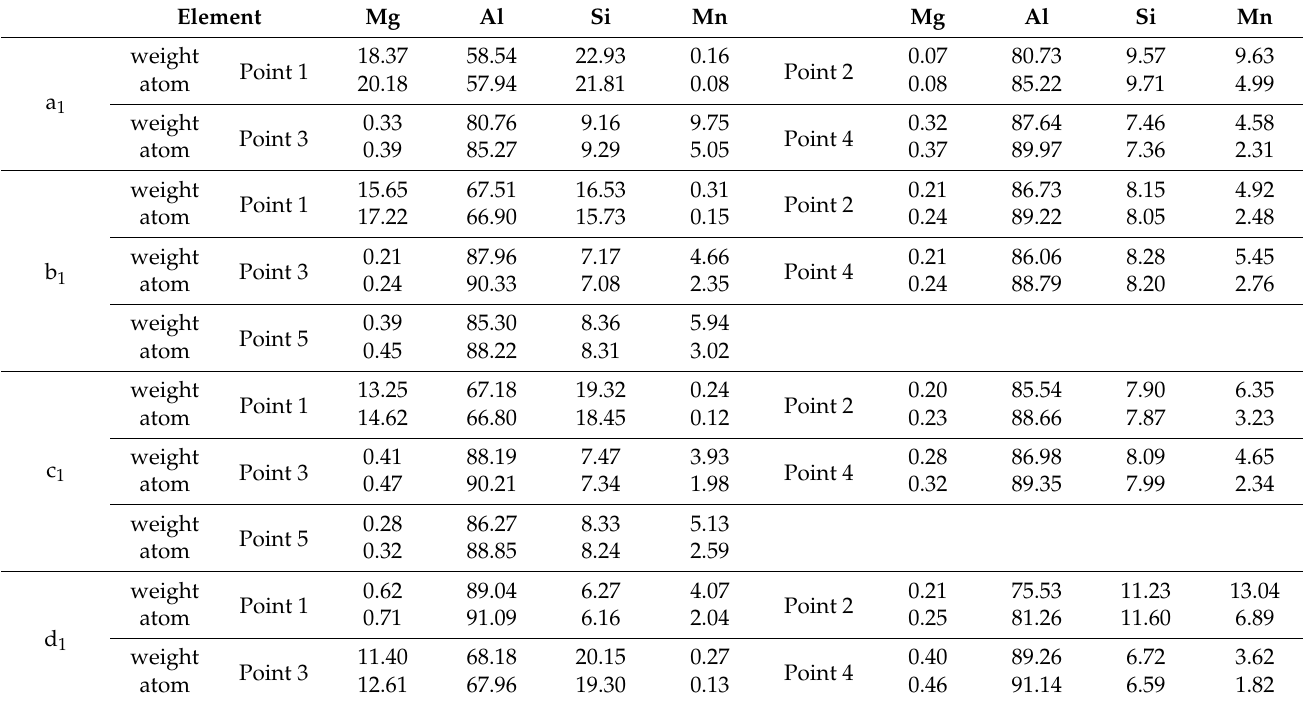
Table 2. Elements and atomic contents of each point